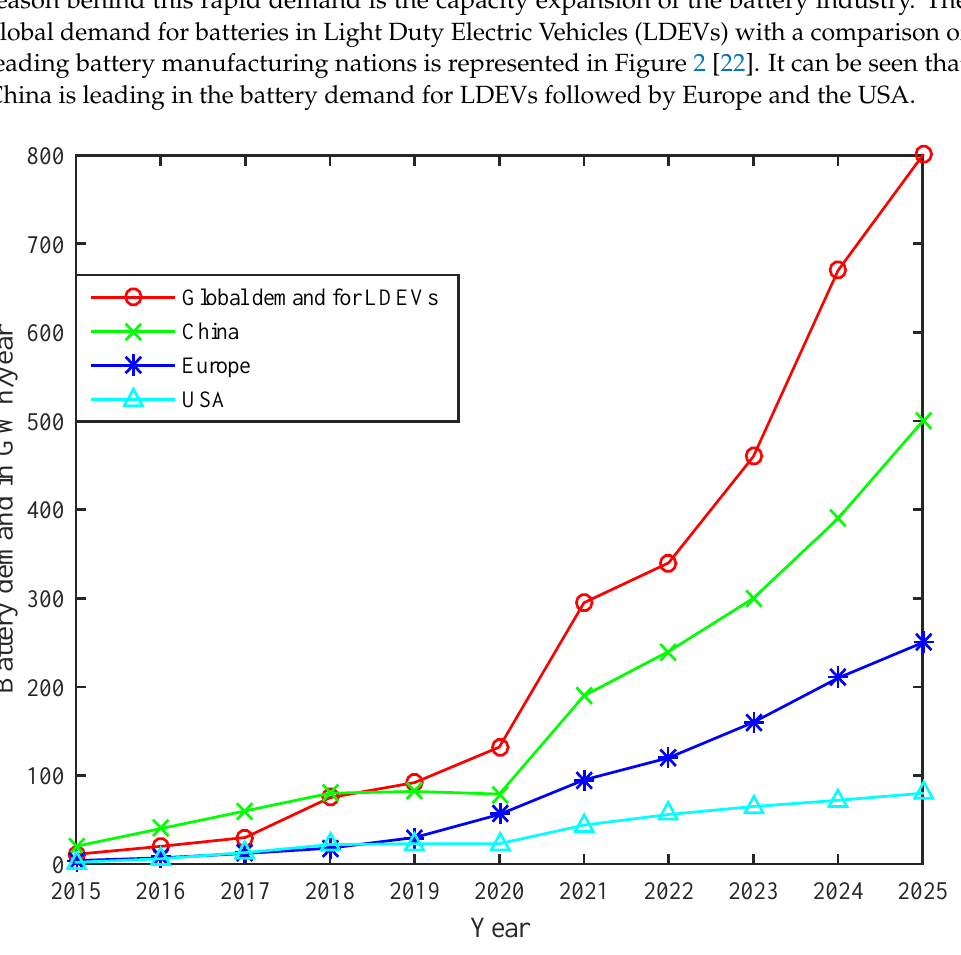
Figure 2. Global demand of batteries in Light Duty Electric Vehicles (LDEVs) and region-wise battery demands.